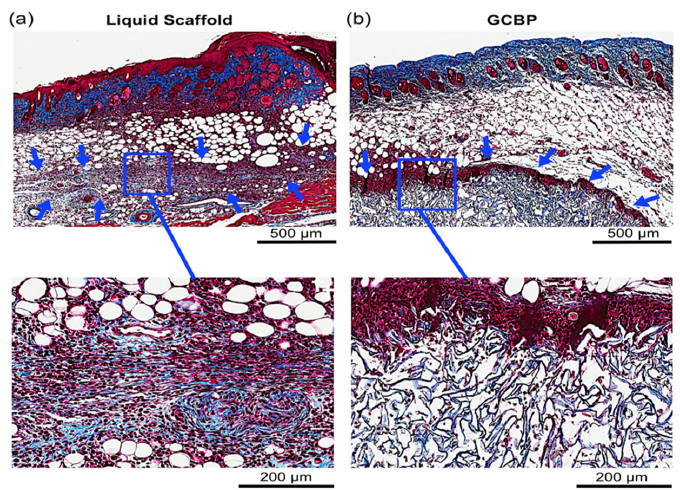
Figure 2. Histological evaluation after 1 week with MT staining. ( a ) Arrows point to the injected Liquid Scaffold. Higher magnification of Liquid Scaffold displays parallel and organized distribution of collagen fibers along the dermis, associated with a remarkable number of cells seen within the matrix. ( b ) Arrows point to the cellular layer surrounding GCBP. Higher magnification of GCBP shows a dense cellular layer encapsulating thick and randomly organized collagen fibers, with limited number of cells detected within the matrix.